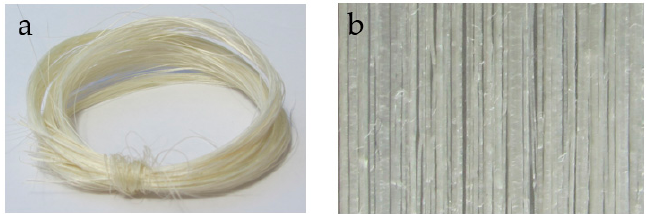
Figure 1. Sisal raw fiber ( a ), single layer of aligned fibers before resin impregnation ( b ).